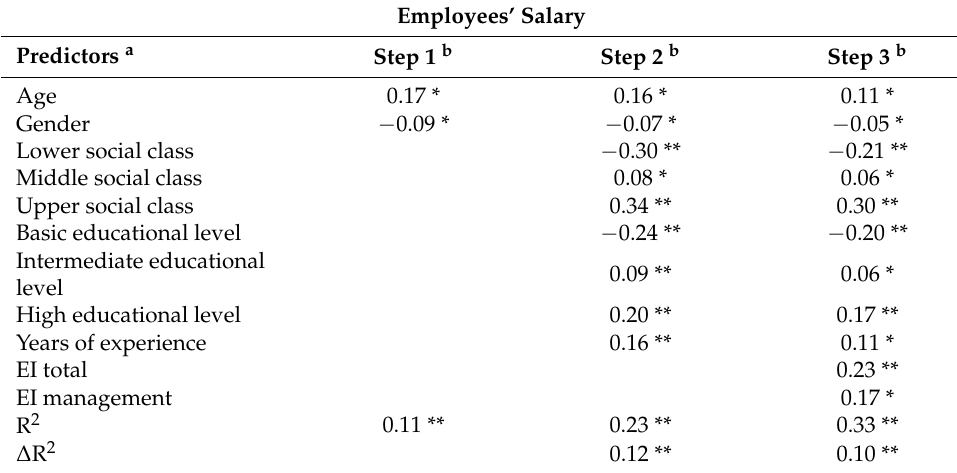
Table 4. Multiple linear regression analysis for the salary